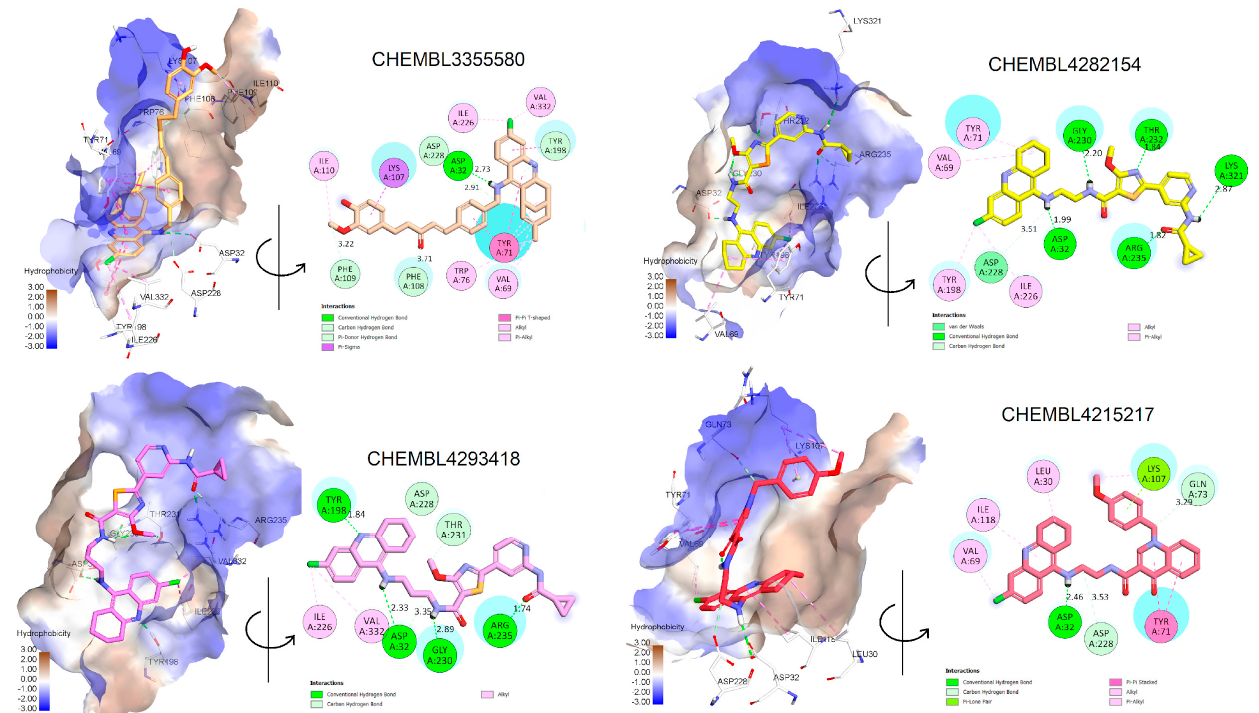
Figure 5. Two- and three-dimensional docking conformations of some exemplary dual inhibitors estimated by experimental and rule − based approaches in the active site of BACE1.